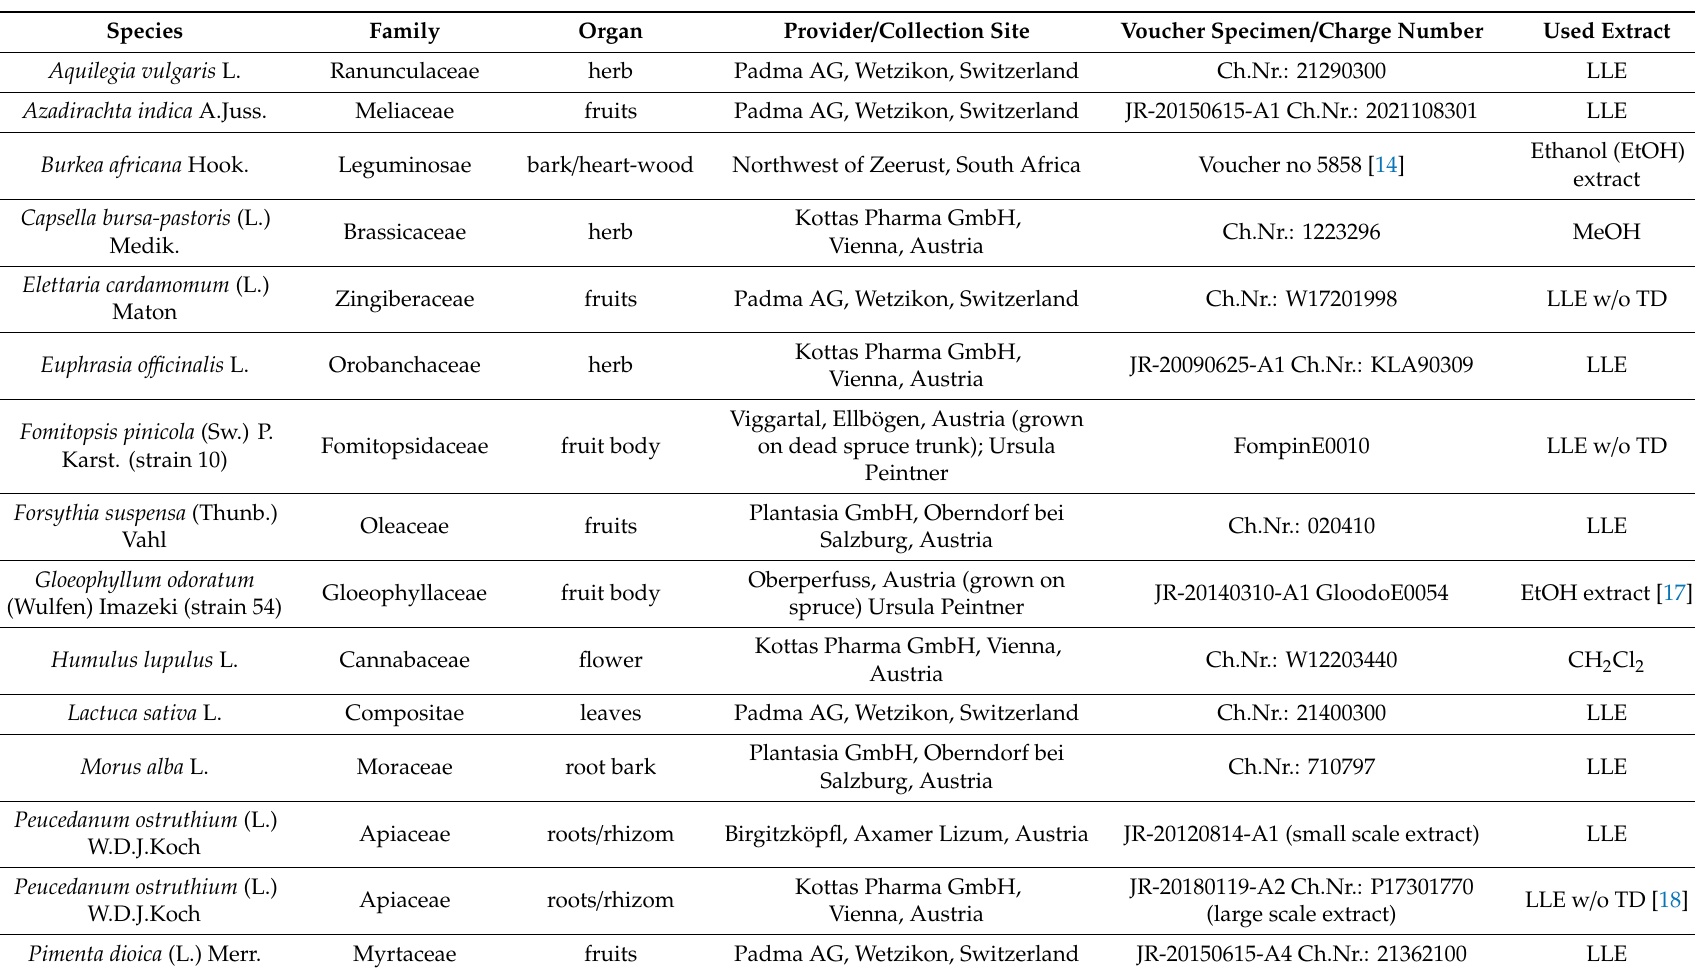
Table 1. Information on used natural materials and extracts (LLE, lead-like enhanced extracts; LLE w / o TD, lead-like enhanced extracts without tannin